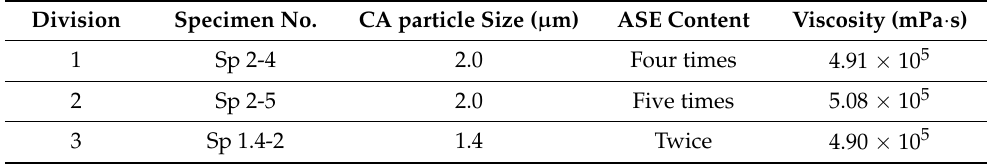
Table 9. Specimens that ensure both workability and oil leakage stability.